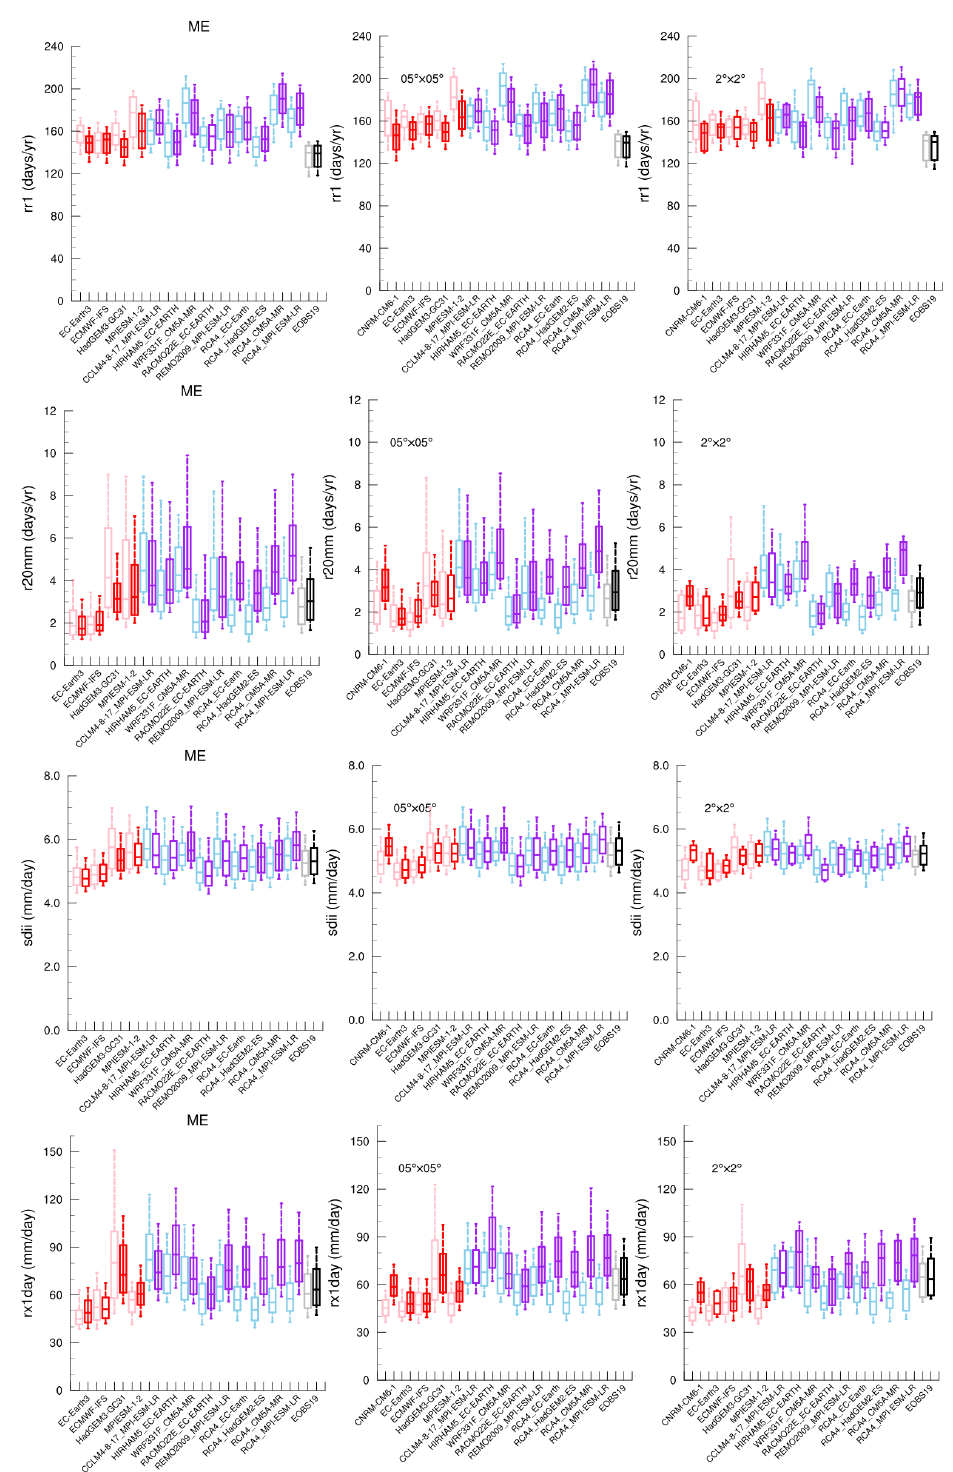
Figure 11. Number of precipitation days (RR1, dyr − 1 , first row), number of days with precipitation amount over 20mm (R20mm, dyr − 1 , second row), simple precipitation intensity index (SDII, mmyr − 1 , third row), maximum 1d precipitation (Rx1day, mmd − 1 , fourth row) in the mid-European region (ME) in the PRIMAVERA LR (pink) and HR (red) models, CORDEX LR (light blue) and HR (purple) models, and E-OBS LR (grey) and HR (black). Left column: model data on their original grids; centre column: all data regridded to 0 . 5 ◦ × 0 . 5 ◦ grid; right column: all data regridded to 2 ◦ × 2 ◦ grid. Boxes mark the 25th and 75th percentiles, with the median inside; whiskers go from the 10th to the 90th percentile. If the high-resolution version of a model is significantly different from the low-resolution version, this is marked with a vertical line in the high-resolution